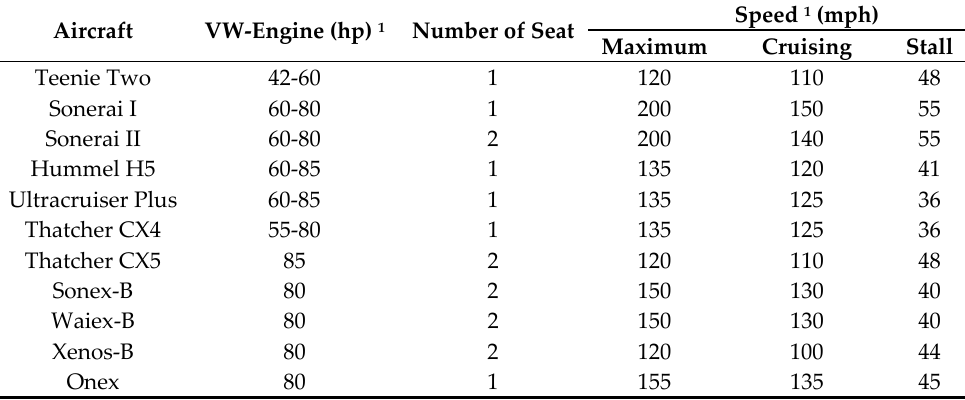
Table 2. List of light sport aircraft using Volkswagen conversion engine [17].